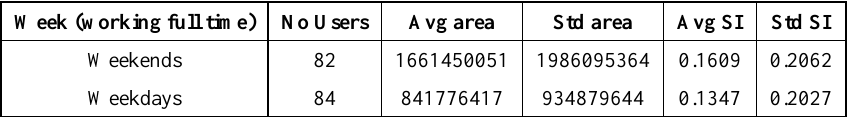
Table 13. Average and standard deviation of area and shape index of full-time job users grouped based on weekdays.